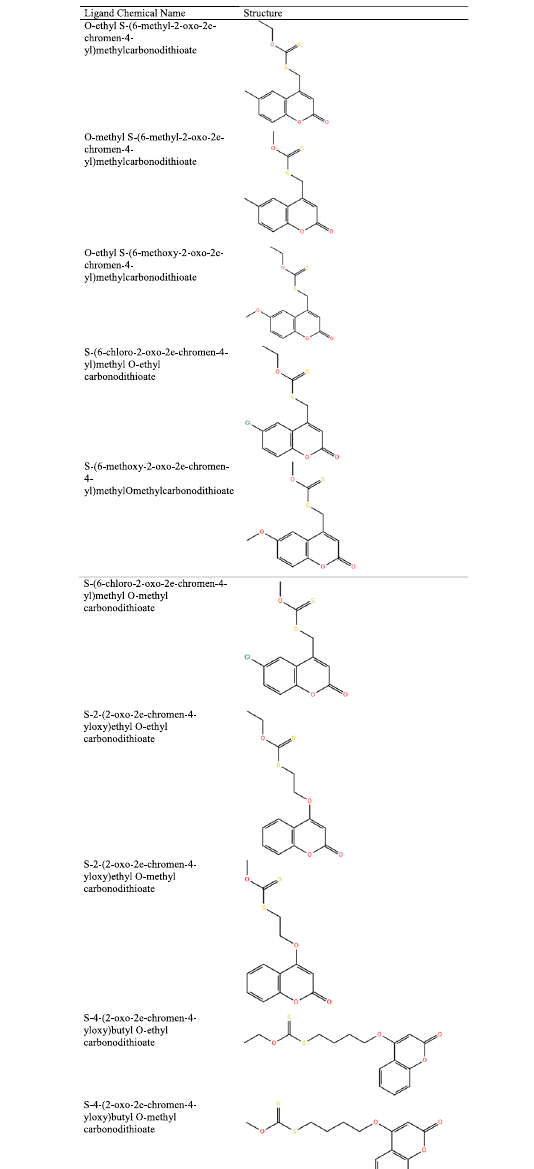
Table 3 Coumarin-carbonodithioate derivatives with their chemical name and structure